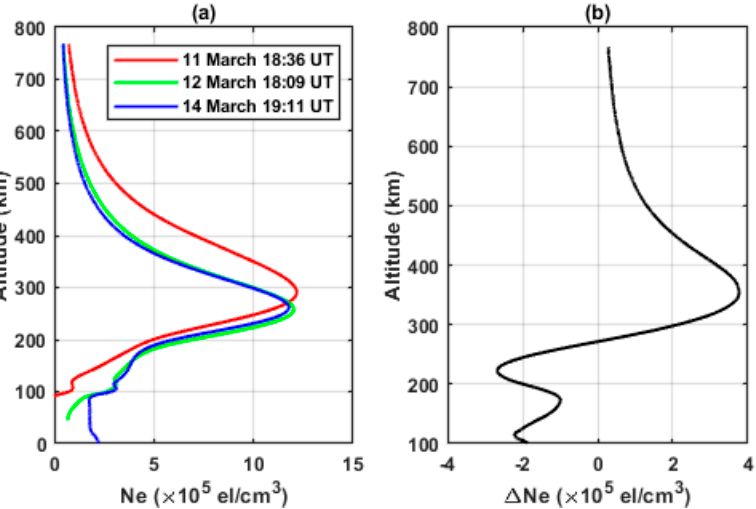
Figure 18. ( a ) The red, green, and blue curves show the IED profiles that occurred during the tsunami (reference period), one day after the tsunami (observation period), and 14 March 2011, respectively. ( b ) The difference in electron density between the reference and observation period. Figure 19 shows the 2 TEC Δ values of PRN 18 observed from the mentioned sta- tions on 10, 11, and 12 March 2011. There are no obvious disturbances in the 2 TEC Δ time series of PRN 18 observed from the four GPS stations on 10 and 12 March. Thus, it is clear that the IGWs propagated during the tsunami, reached the F2 layer peak altitude and caused electron density disturbances.